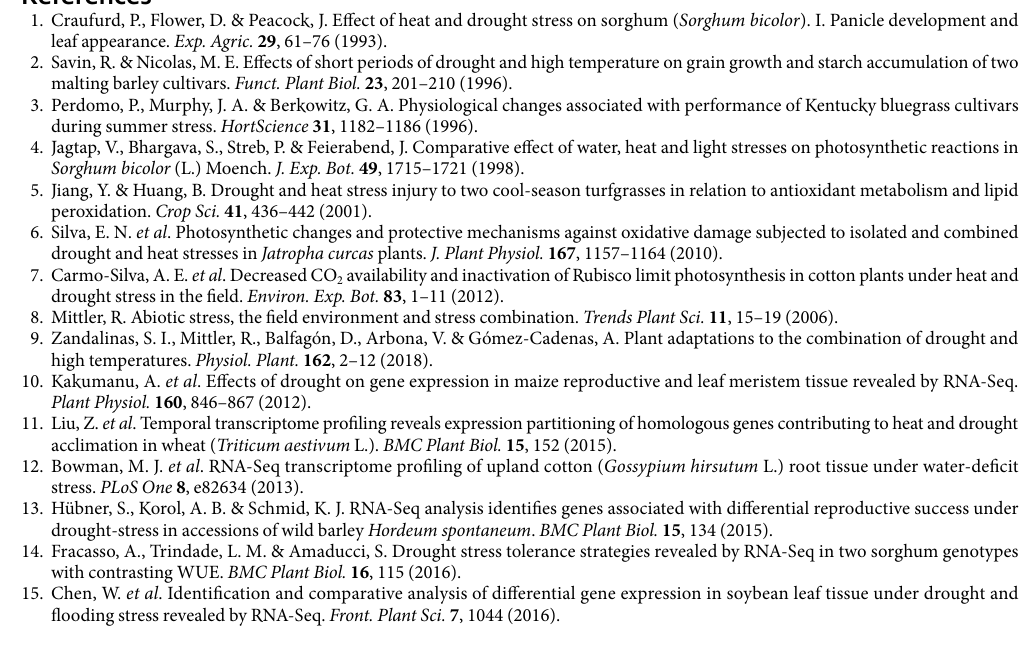
NY). The synthesized cDNA was amplified in a StepOnePlus Real-Time PCR system (Life Technologies, Grand Island, NY) using the following parameters: pre-heat cycle of 95 °C for 3 min, 40 cycles of 95 °C denaturation for 30 sec per cycle, and 60 °C annealing/extension for 30 sec per cycle. Power SYBR Green PCR Master Mix (Life Technologies, Grand Island, NY) was the intercalating dye used to detect gene expression level. Gene name, accession number, forward and reverse primer sequences are provided in Table 4. A melting curve analysis was performed for each primer set to confirm its specificity. Actin was used as the reference gene, since its expres- sion was consistent throughout treatments. A ΔΔ Ct method was used to calculate the relative expression level between genes of interest and reference gene, respectively 85 . Four biological replicates (n = 4) were performed for each gene under either control or stress conditions, respectively. Statistical differences between treatment means were separated by Student’s t-test at the P level of 0.05.